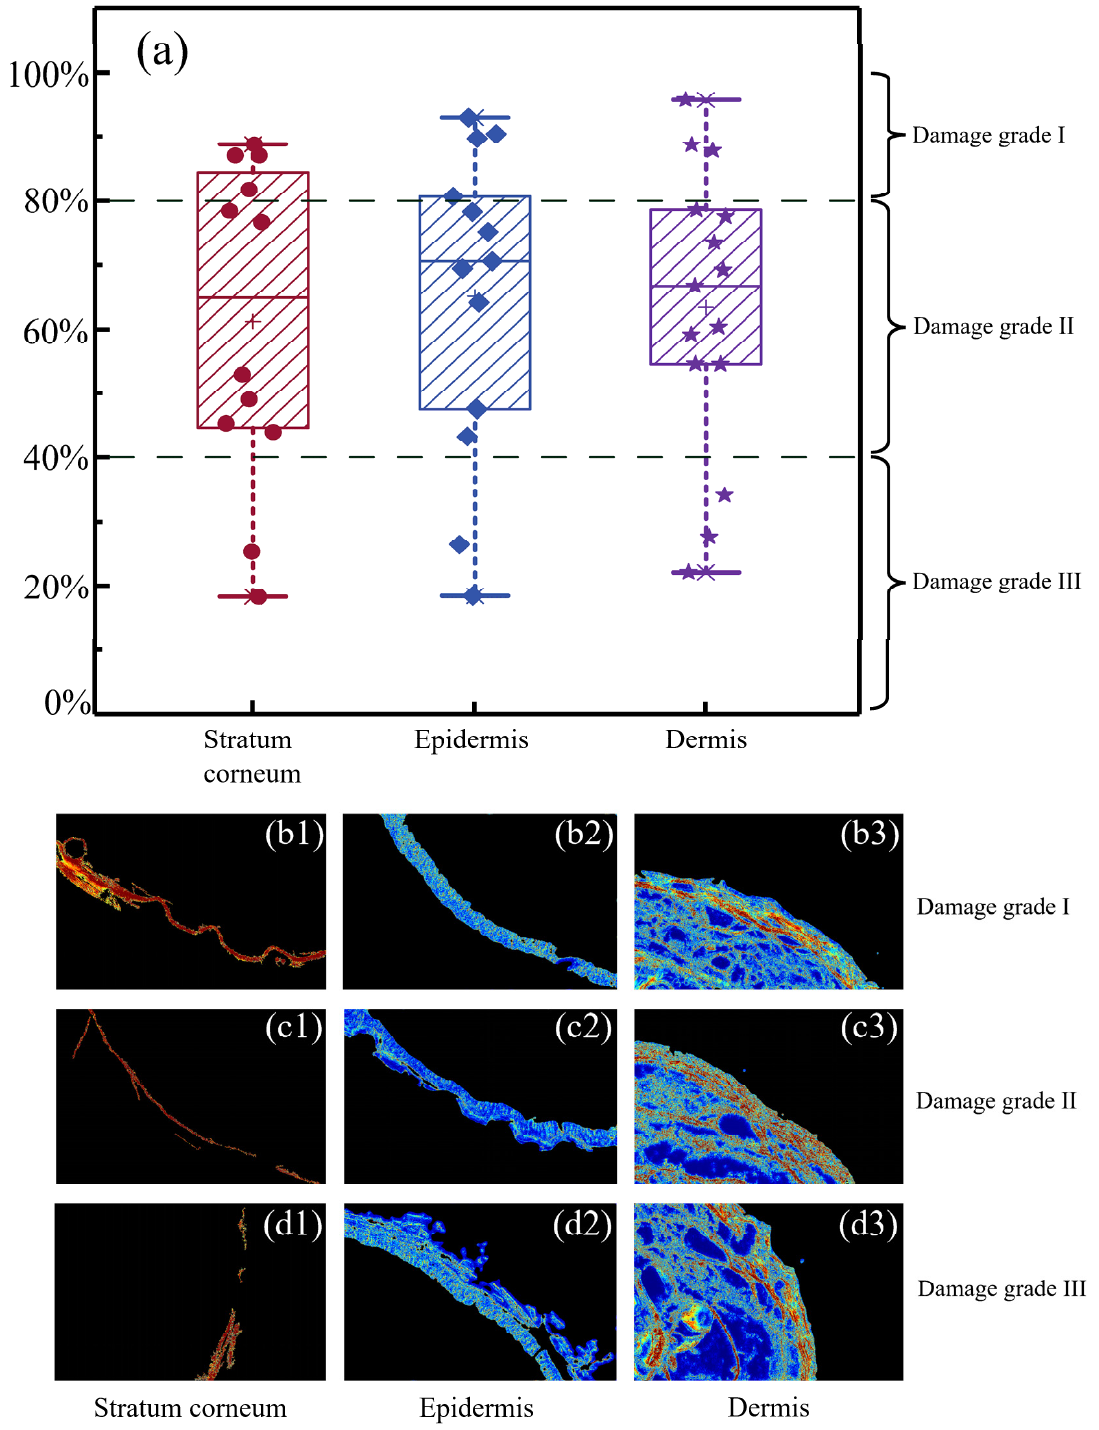
Figure 4. Q-Health index analyzing results: ( a ) Q-Health index distributions of all samples, the red dots represent the Q-Health values of the damaged stratum corneum samples, the blue diamonds represent the Q-health values of the damaged stratum corneum samples, the purple pentagrams represent the Q-health values of the damaged dermis samples, the “ × ” symbols represent the maximum and minimum Q-health values of each group, and the “ + ” symbols represent the average Q-health values of each group; ( b1 – b3 ) stratum corneum, epidermis, and dermis samples of damage grade I; ( c1 – c3 ) stratum corneum, epidermis, and dermis samples of damage grade II; ( d1 – d3 ) stratum corneum, epidermis, and dermis samples of damage grade III.